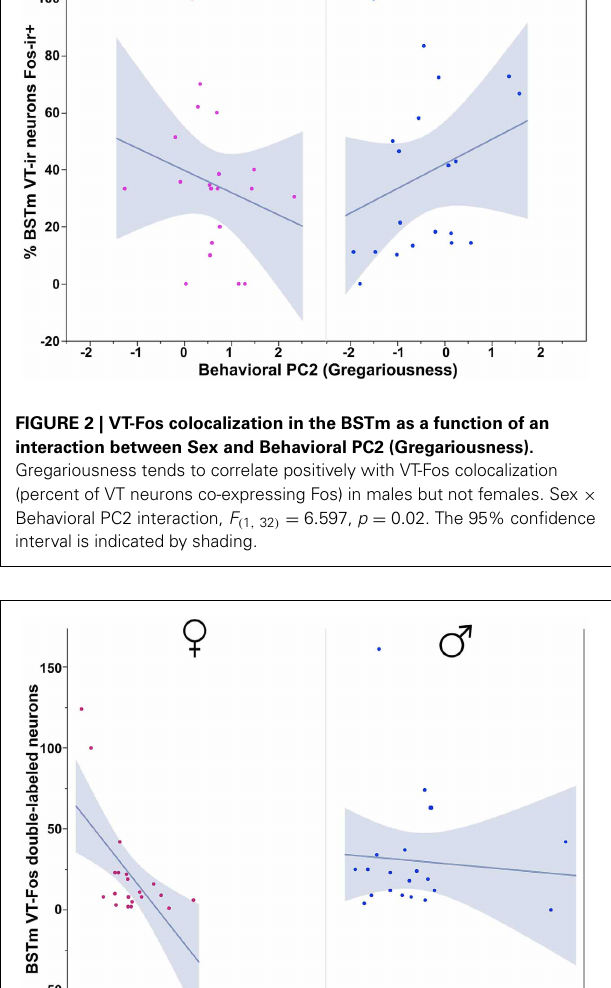
Sex [ F ( 1 , 32 ) = 5 . 04, p = 0 . 03; females, 38.4 ± 3.5%;